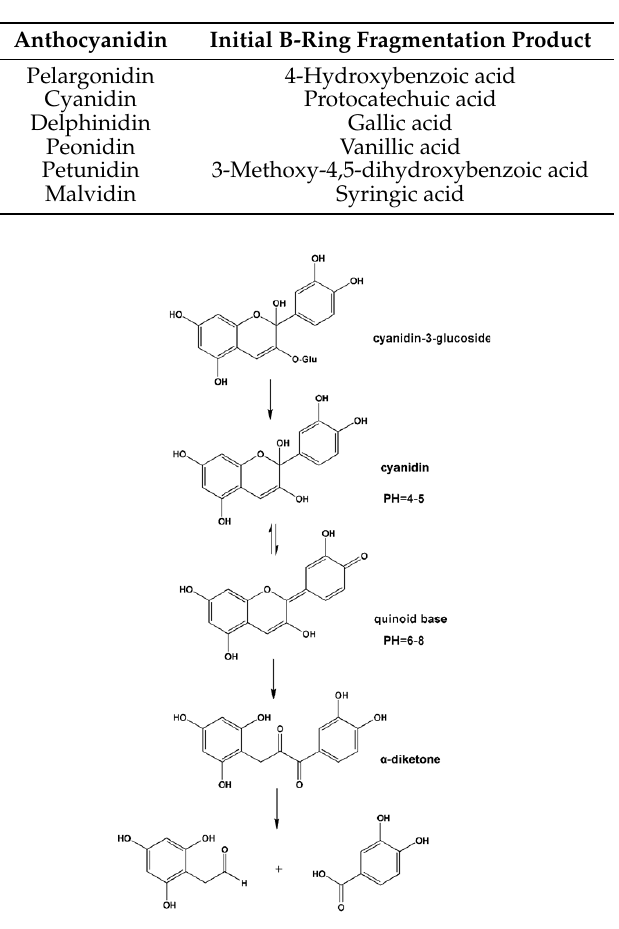
Figure 4. pH-dependent structural changes and degradation of cyanidin-3-glucoside. Reproduced from the original source [94].